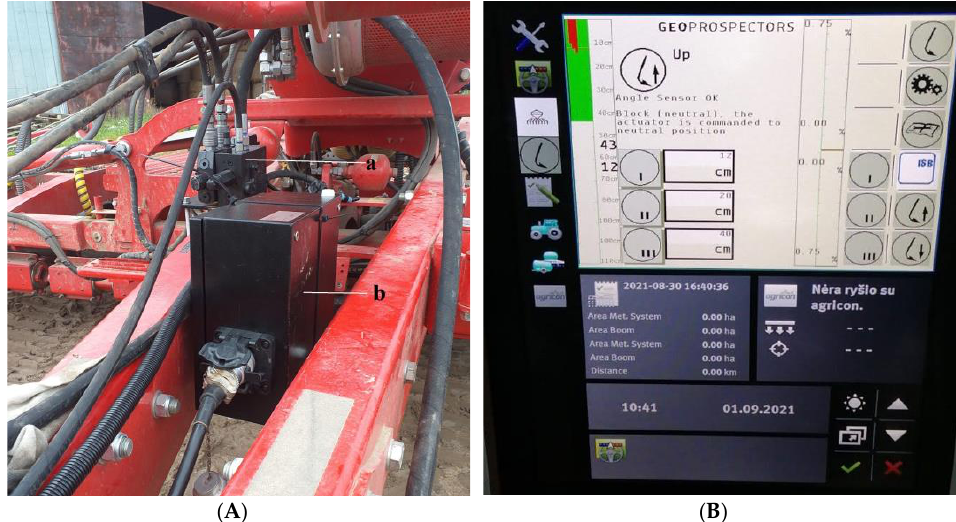
Figure 3. ( A ) Modification of the seeder: (a) hydraulic block valve with a multi-phase motor; (b) DXC Implement Control ECU (ISOBUS job calculator). ( B ) Start VT of the Implement ECU on TOUH 1200 muller terminal (photographed by Marius Kazlauskas).